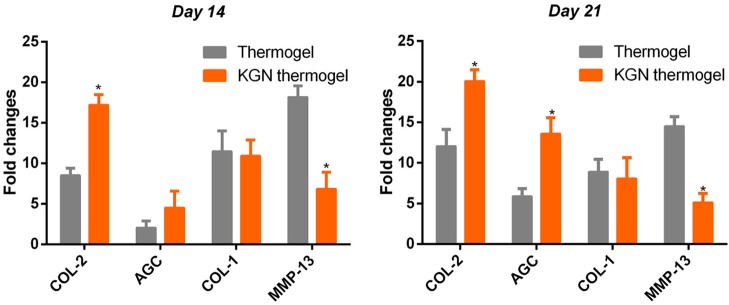
Expression of cartilage-related genes of COL-2 and AGC, COL-1, and MMP-13 of OA chondrocytes within thermogel with or without KGN (n = 3; *p < 0.05).